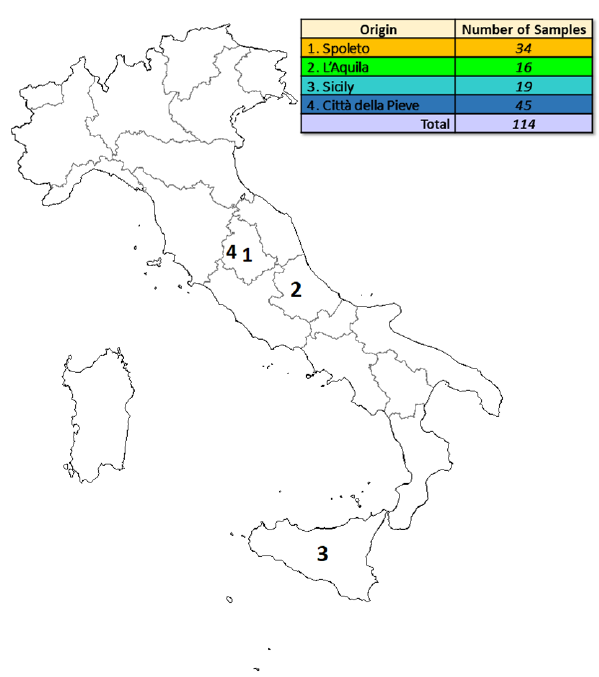
Figure 5. Details about the origin and the numerosity of the analyzed samples.